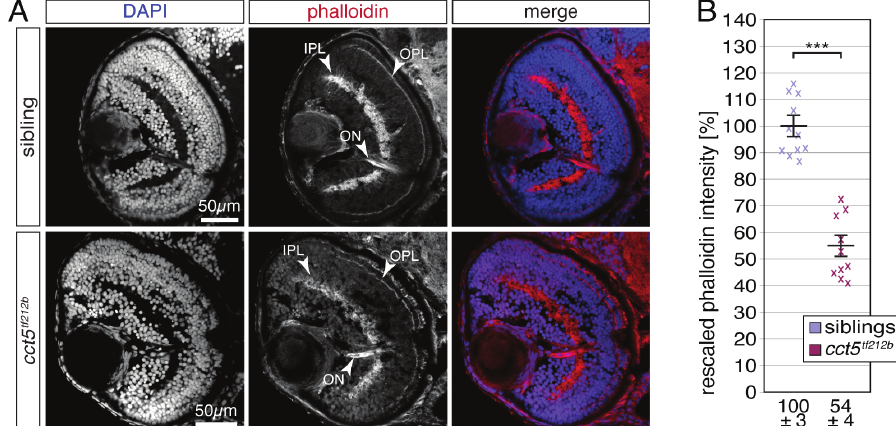
Figure 3. F-actin is significantly reduced in the retina of cct5 𝑡𝑓121𝑏 mutants. (A) At three dpf, F-actin was labelled with phalloidin (red) on cross sections counterstained with DAPI (blue). Whereas the inner and outer plexiform layers of the retina (IPL and OPL, respectively) were prominently stained by phalloidin within siblings, the signal from cct5 𝑡𝑓121𝑏 homozygotes appeared weaker. Phalloidin also marked the optic nerve (ON). (B) Quantification of the brightness of the phalloidin signal within the IPL revealed that cct5 𝑡𝑓121𝑏 homozygotes showed a significant reduction in signal intensity to 54 ± 4% in relation to their siblings, which were rescaled to 100 ± 3%. Data are mean ± SEM; *** P < 0.001 by Student’s t -test; n = 10.